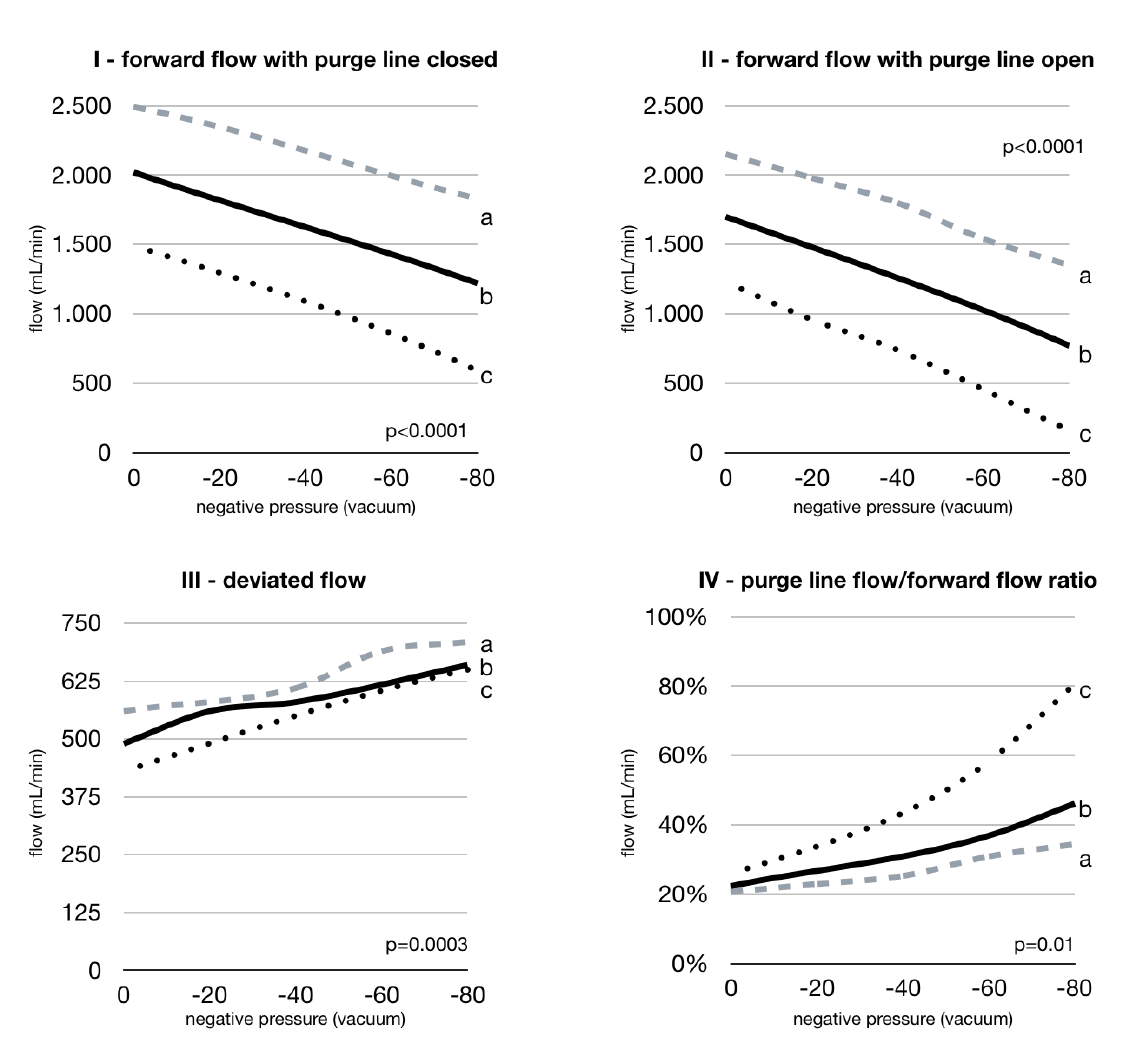
Fig. 3 – Influence of the negative pressure applied to venous reservoir and to the initial forward flow (arterial line flow) of 2500 mL/min (a), 2000 mL/min (b), and 1500 mL/min (c); with the purge line closed (I) and purge line open (II); to the deviated flow (III); and percentage of purge line flow/forward flow ratio